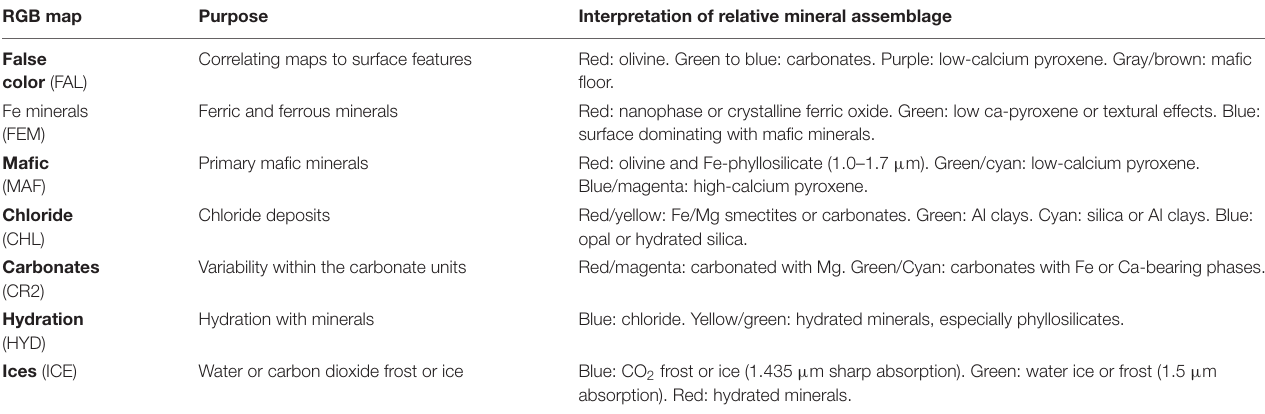
TABLE 2 | Interpretation made on the basis of summary products derived using the CRISM data as RGB color